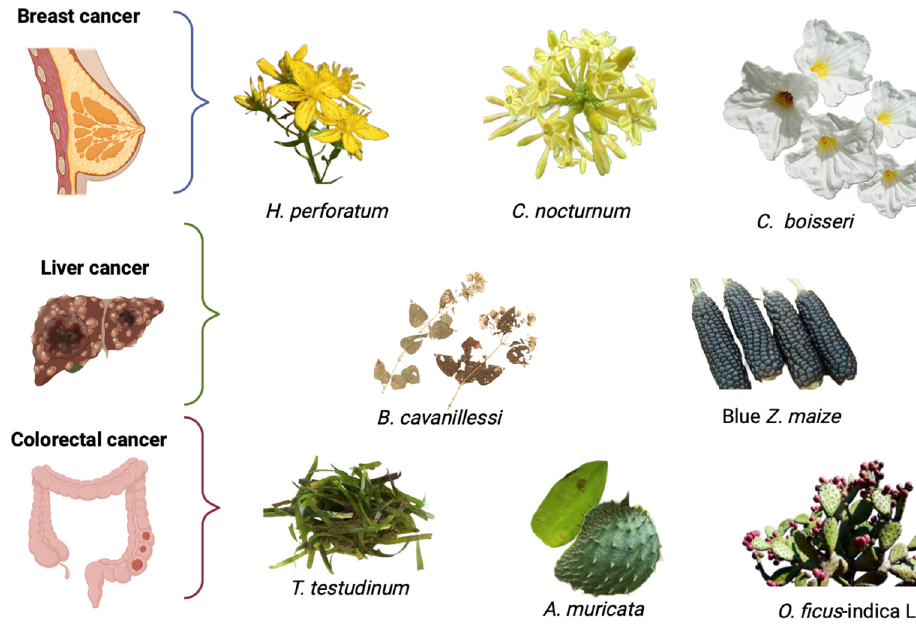
Figure 2. Mexican medicinal plants used for the treatment of different types of cancer. The images were taken from the World Checklist of Selected Plant Families, WCSP record.